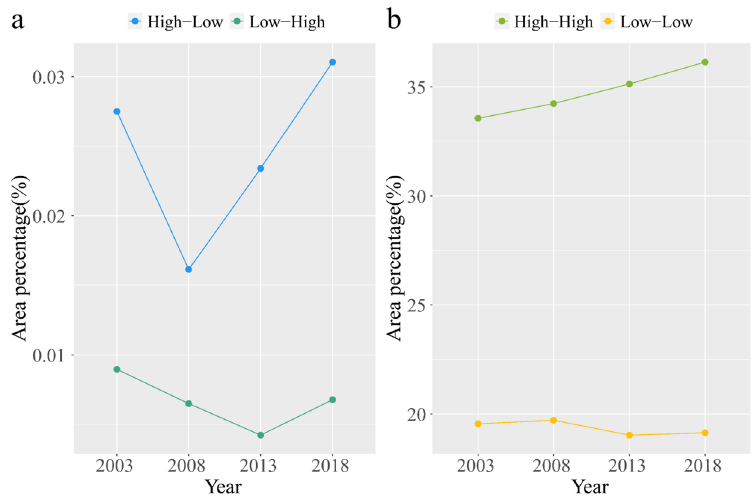
Figure 10. Temporal trends of ( a ) “High–Low” (HL), “Low–High” (LH) and ( b ) “High–High” (HH),“Low–Low” (LL) LISA index in the QBM, 2003–2018.